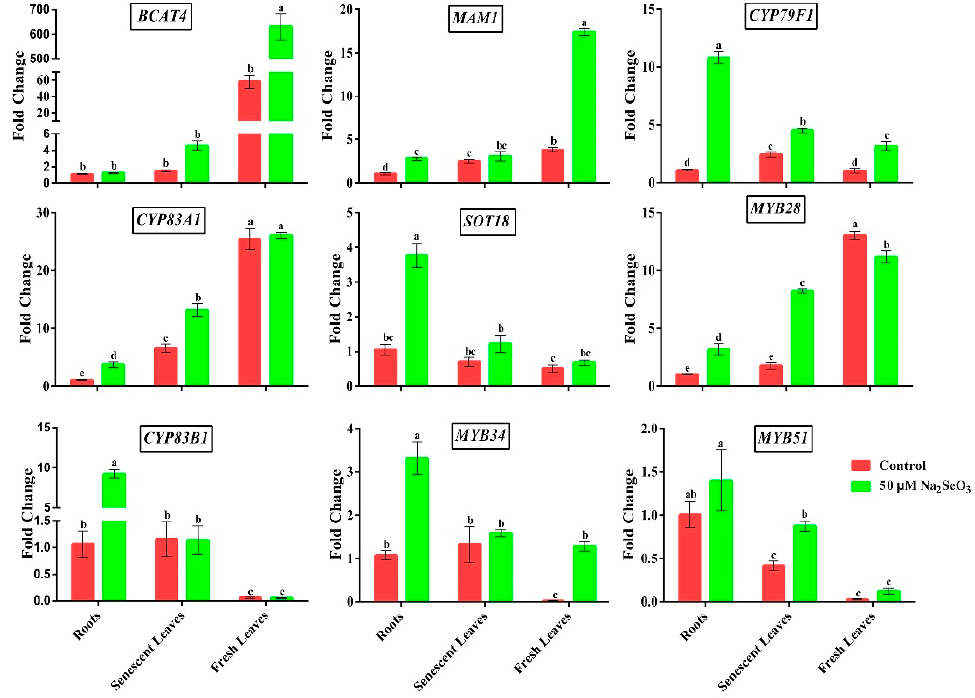
Figure 5. Effect of Se on the transcript levels of these genes involved in GSLs biosynthesis. Different letters indicate significant differences compared to roots under control.